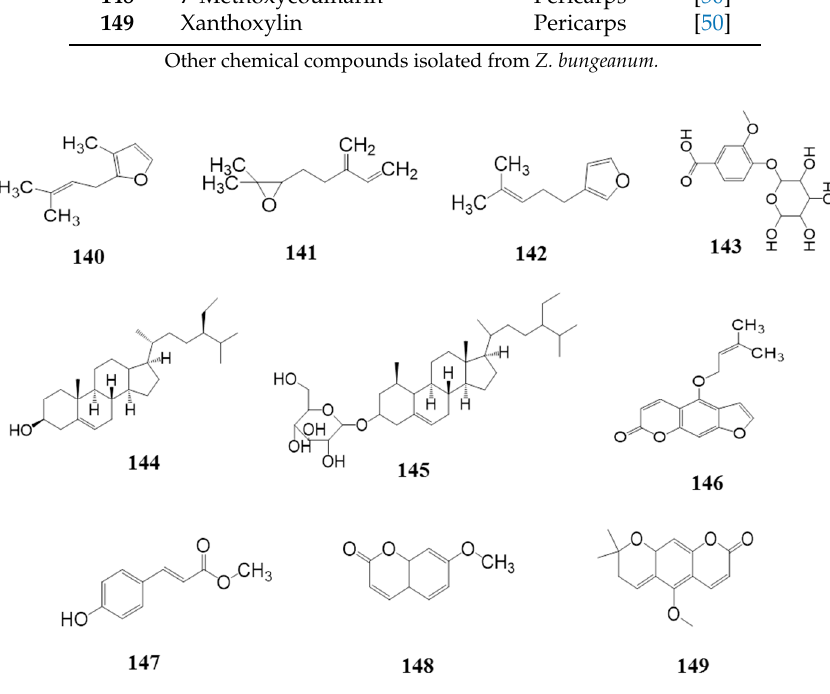
Figure 7. Other chemical structures in Z. bungeanum .